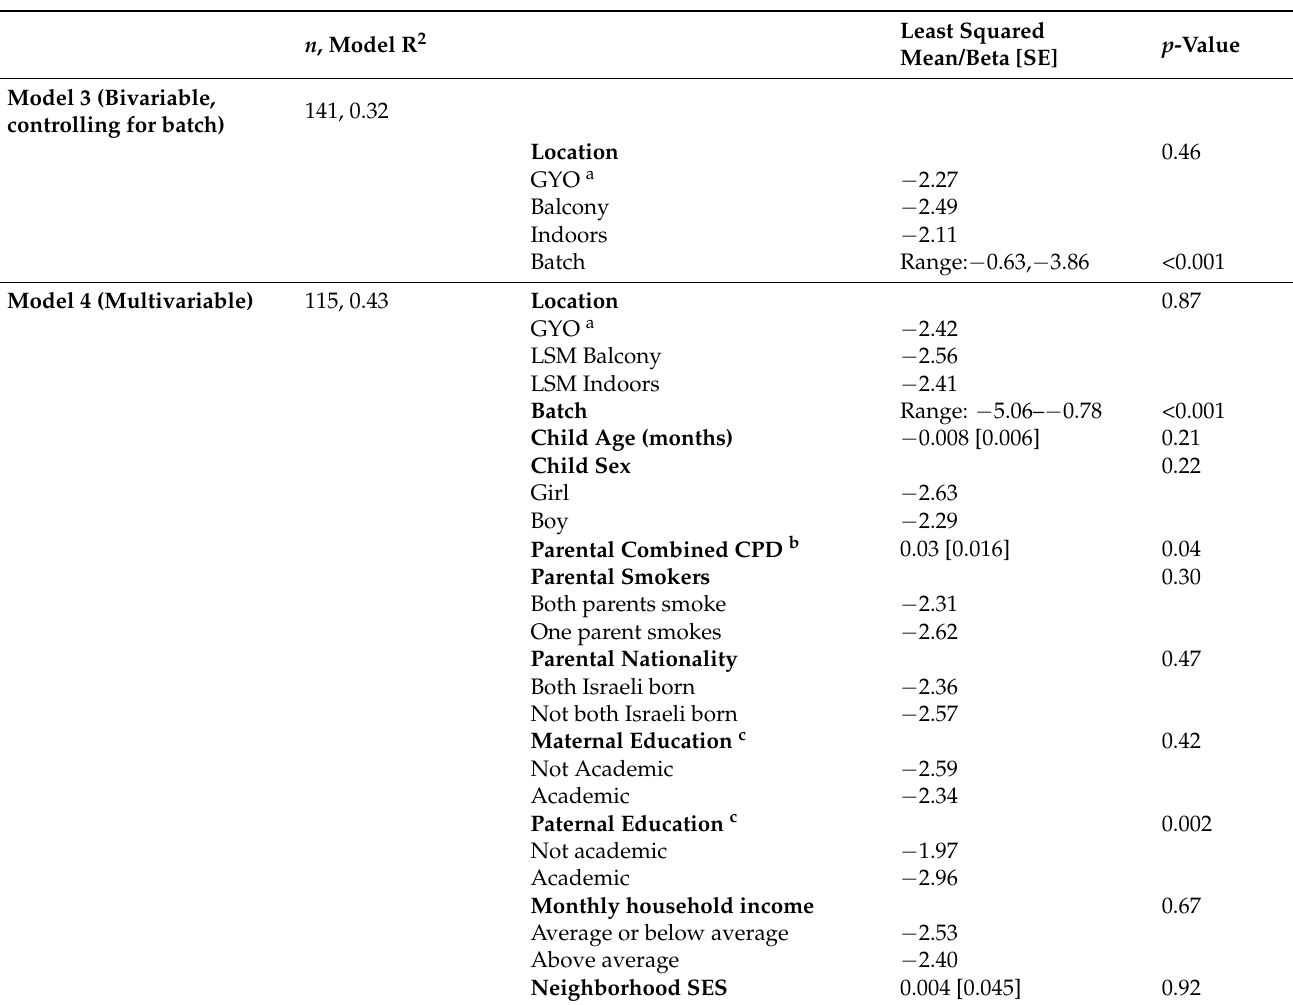
Table 3. Linear regression analyses examining child exposure as assessed by hair nicotine (log hair nicotine) and by usual location of smoking. n , Model R